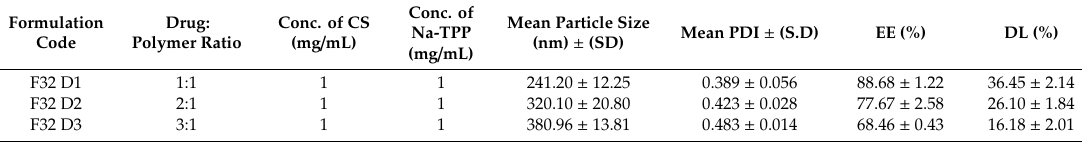
Table 2. Optimization of midazolam (MDZ)-loaded CS NPs.